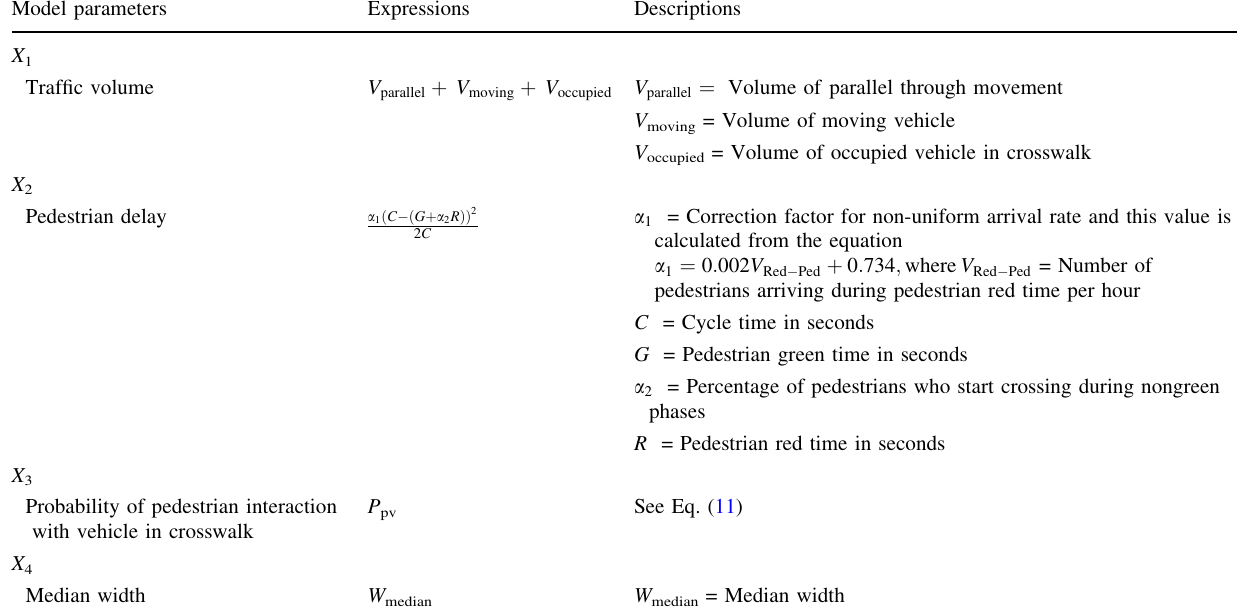
Table 6 Model parameters with descriptions Model parameters Expressions Descriptions